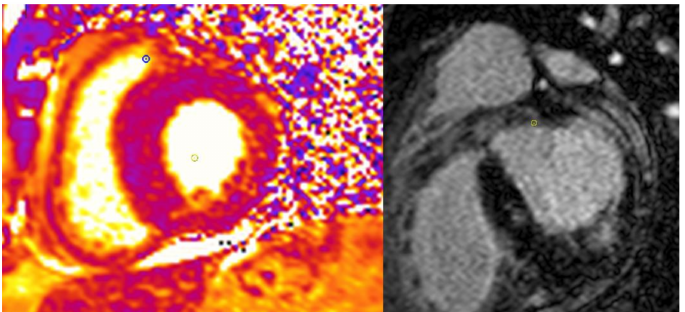
Figure 8. ( Left ) CMR T2 map with increased relaxation times representing oedema and inflammation within the myocardium in a patient with advanced Fabry cardiomyopathy; ( Right ) CMR LGE images with areas of LGE in the inferior and inferolateral walls of the myocardium which correspond with areas of high T2.